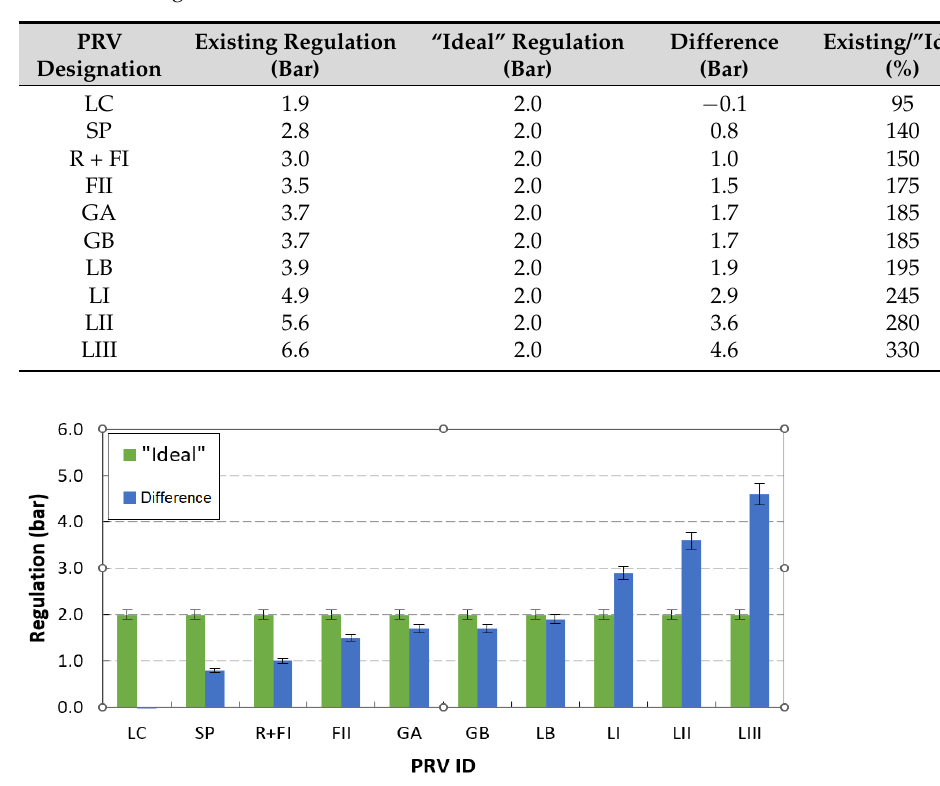
Figure 8. Measured and simulated pressure values.